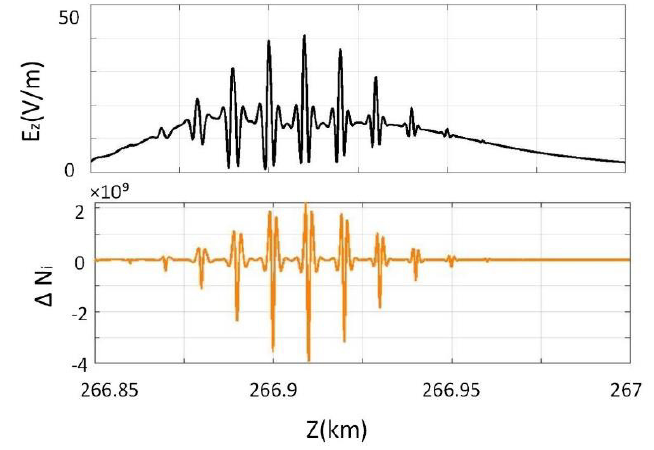
Figure 9. (1) Vertical electric field | E z | ( top ); (2) ion density perturbation ∆ N i in the altitude range of 266.85 − 267 km at 1.5194 ms ( bottom